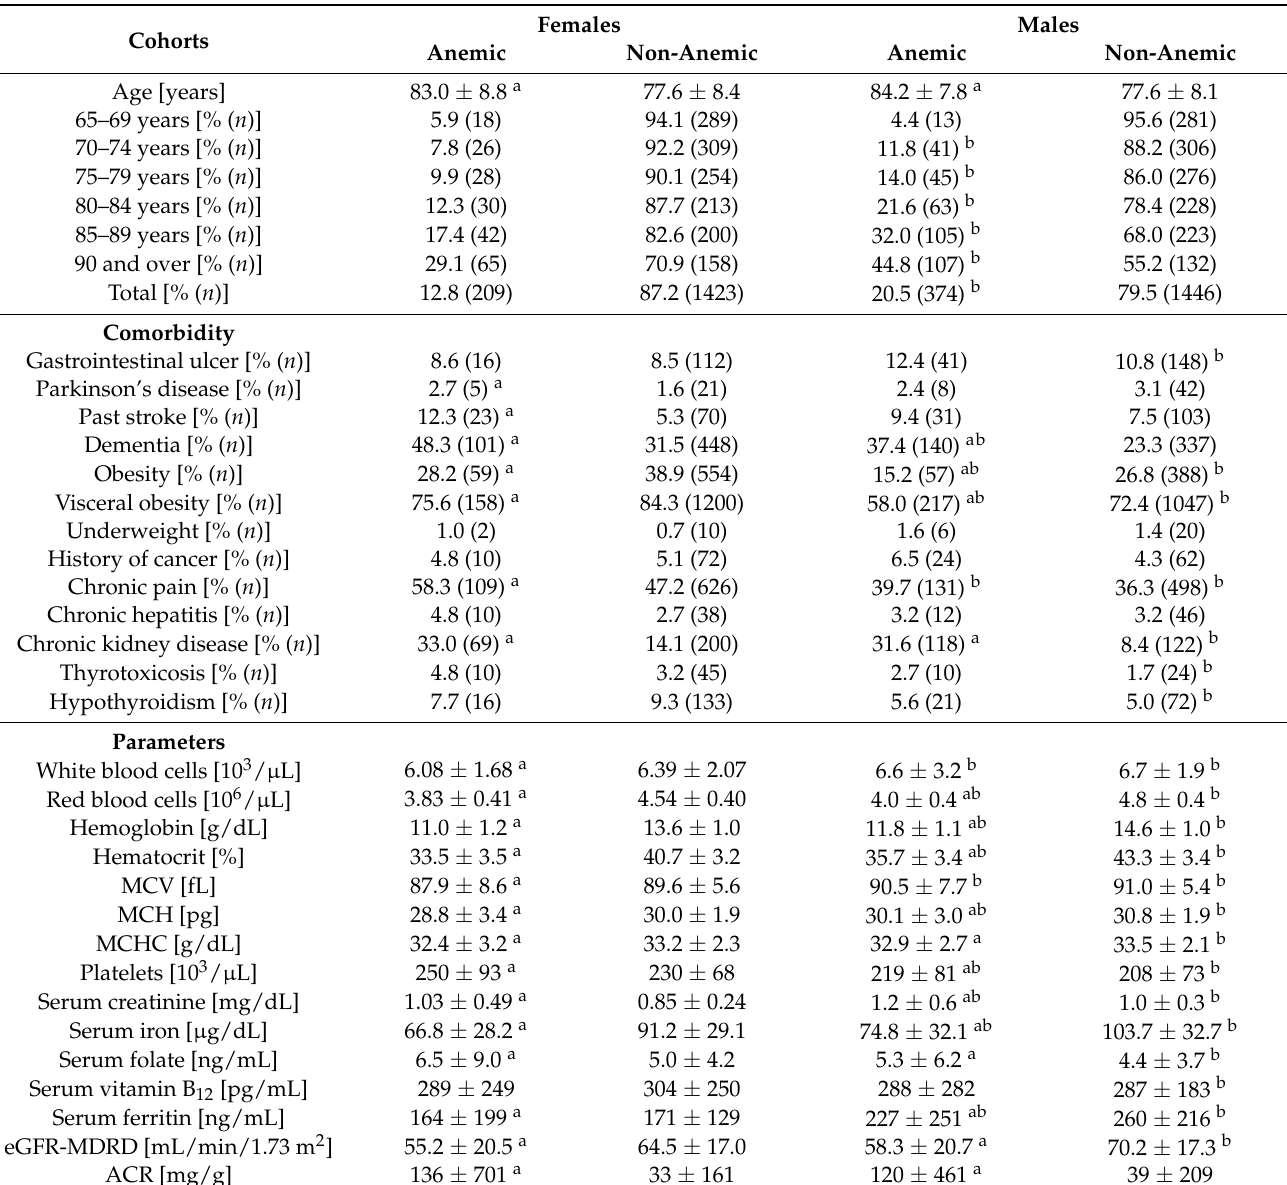
Table 1. Characteristics of female and male participants of the PolSenior study with or without anemia. Quantitative data presented as mean values ± standard